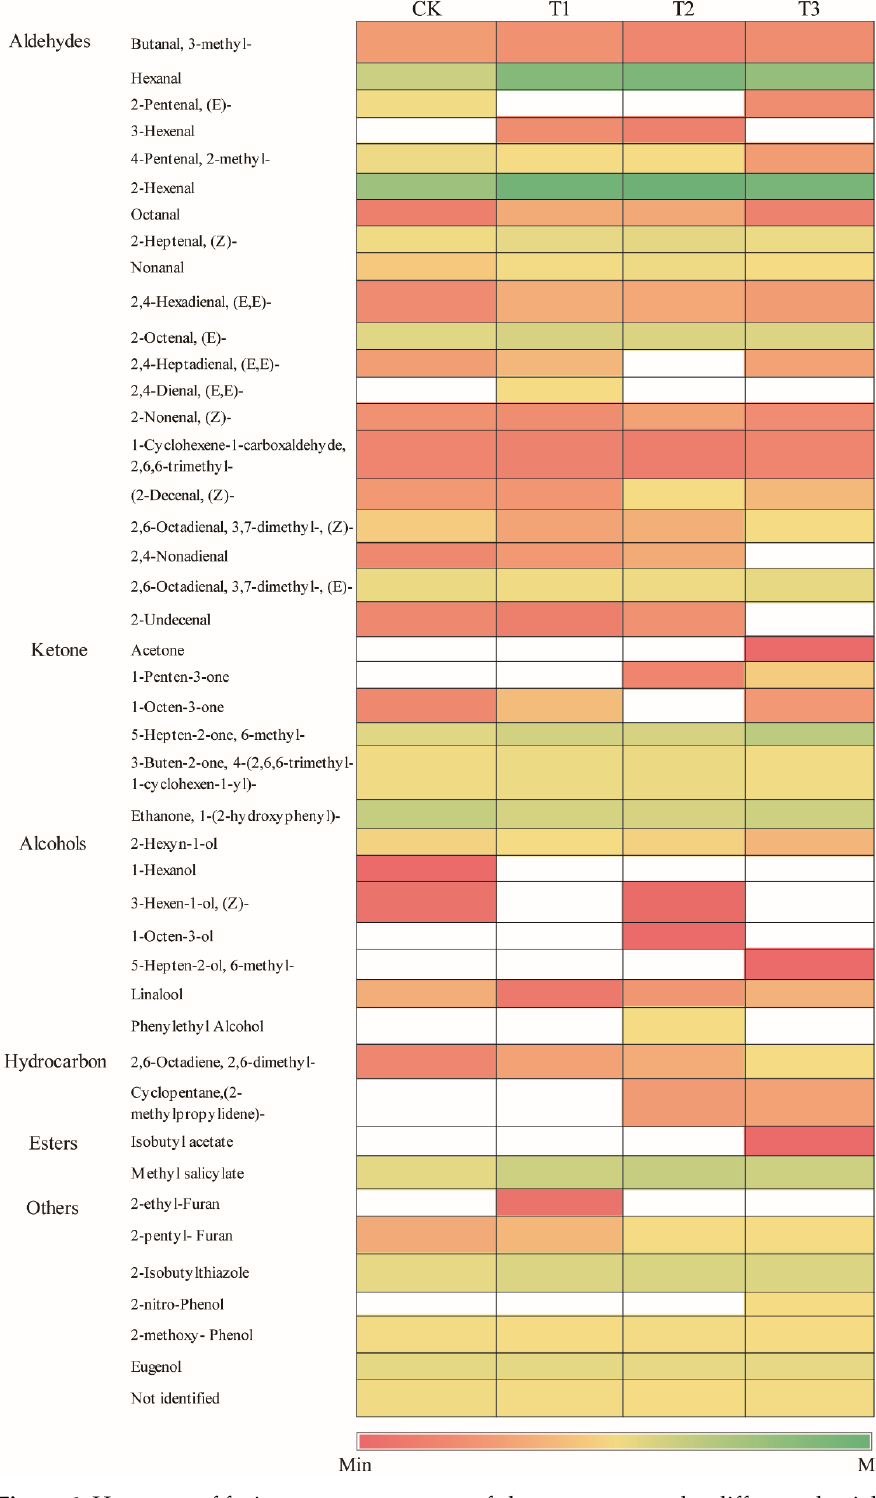
Figure 6. Heat map of fruit aroma components of cherry tomato under different abaxial leafy sup- plemental lighting treatments. White indicates no data, and the red minimum and green maximum values for the heat map are shown in the color scale